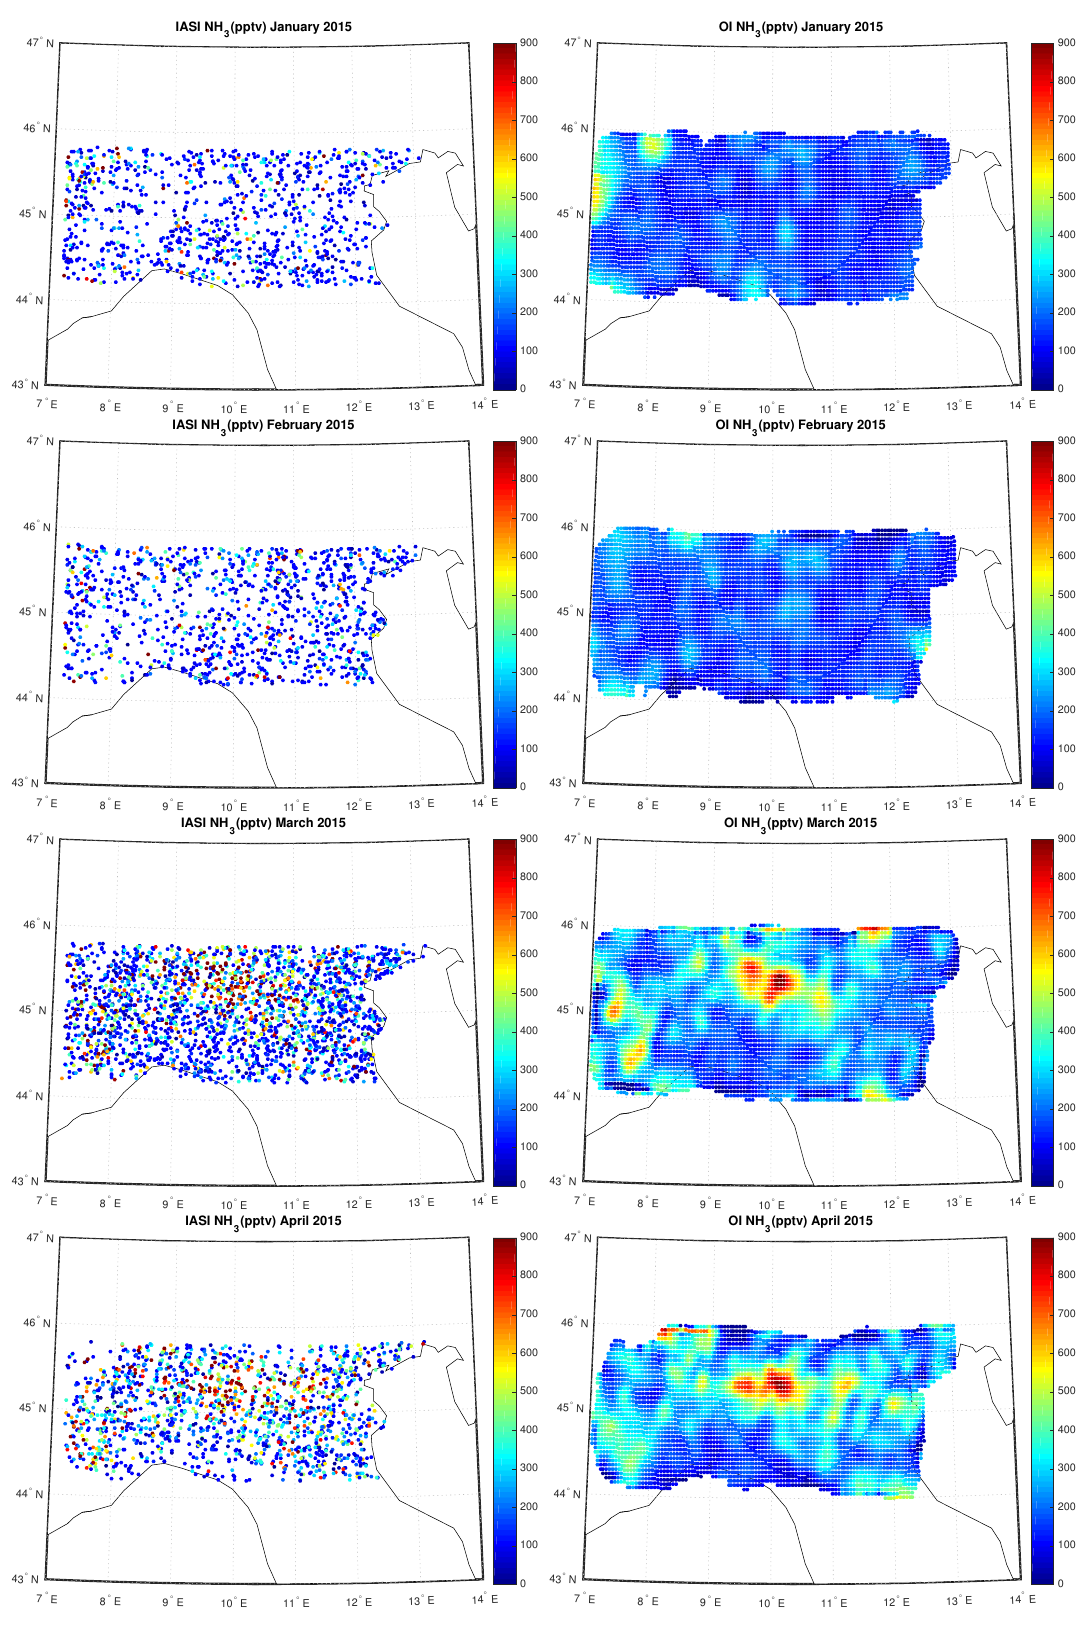
Figure 11. IASI and OI NH 3 over Po-Valley for the period January–April